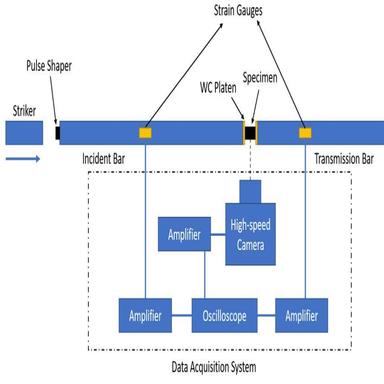
Schematic of the modified split Hopkinson pressure bar (SHPB) experimental setup.